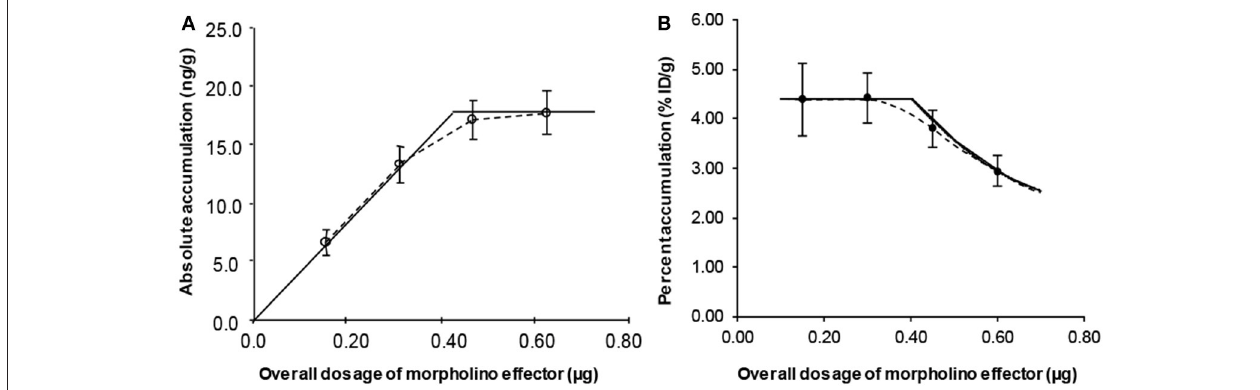
FIGURE 3 | The percent (A) and absolute (B) tumor accumulations of a small cMORF against its dosage. The solid lines are obtained from our semi-empirical model rather than from regression fits.